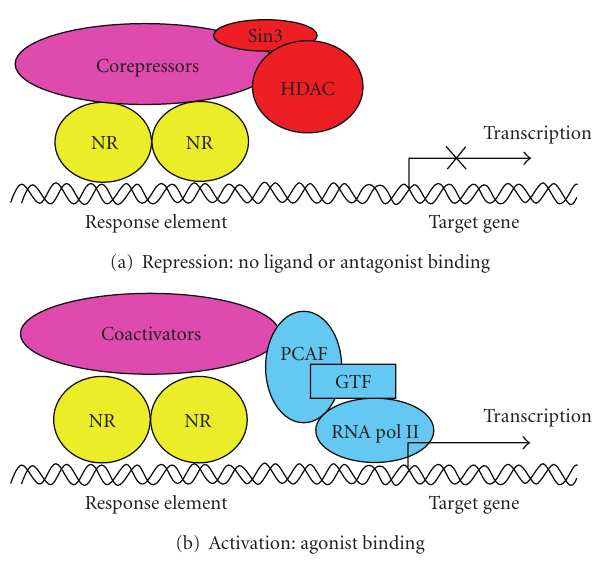
Figure 2: Activation and repression of nuclear receptor activity. (a) In the absence of ligand, nuclear receptors (NRs) are associated with corepressor complexes that bind Sin3 and histone deacetylase (HDAC), thereby turning o ff gene transcription. Some steroid receptors can recruit this complex when they are occupied by antagonists although they do not seem to be associated with corepressors in the unliganded state. (b) In the presence of ligand, NRs generally recruit coactivator complexes, PCAF histone acetyltransferase protein, general transcription factors, and RNA polymerase II to induce gene transcription. GTF: general transcrip- tion factor; RNA pol II: RNA polymerase II; PCAF: P300/CBP- associated factor.